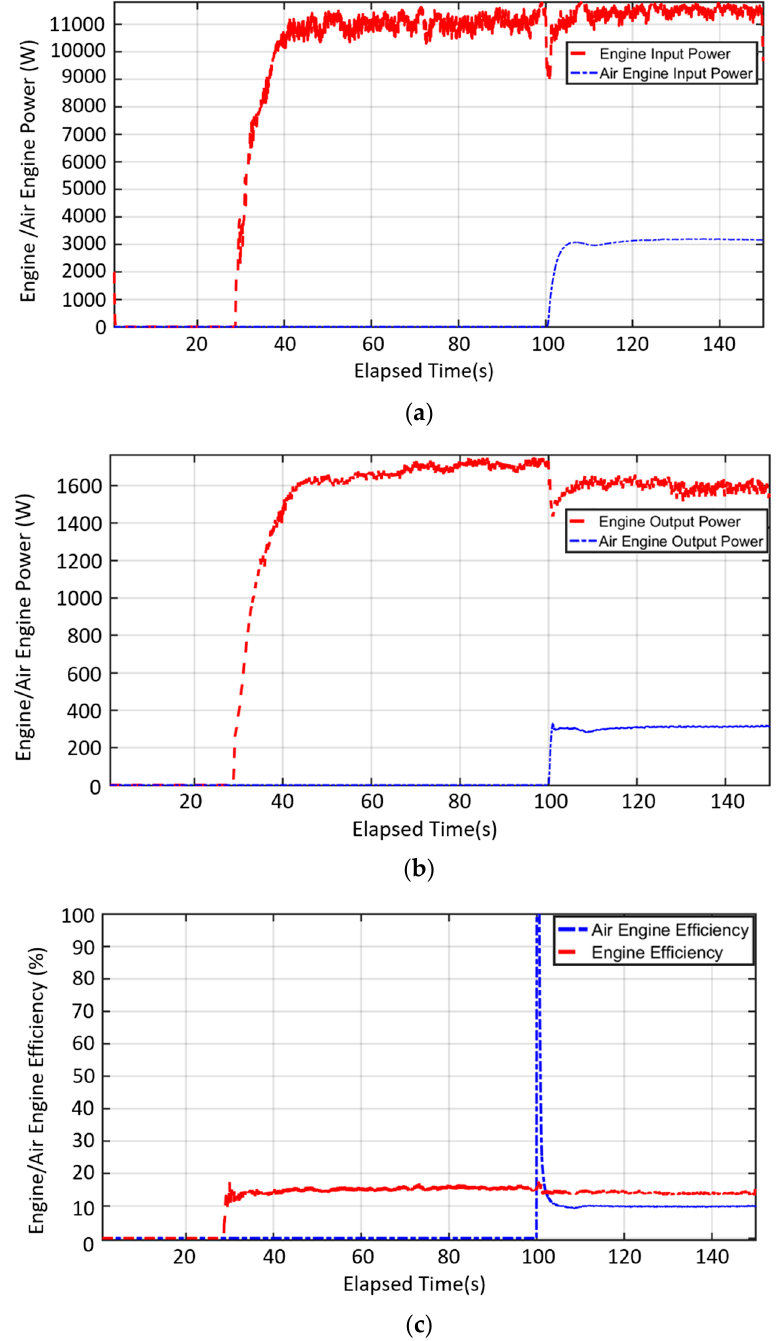
Figure 15. Engine/air engine hybrid mode: ( a ) input power; ( b ) output power; and, ( c ) efficiency . Figure 15. Engine / air engine hybrid mode: ( a ) input power; ( b ) output power; and, ( c ) e ffi